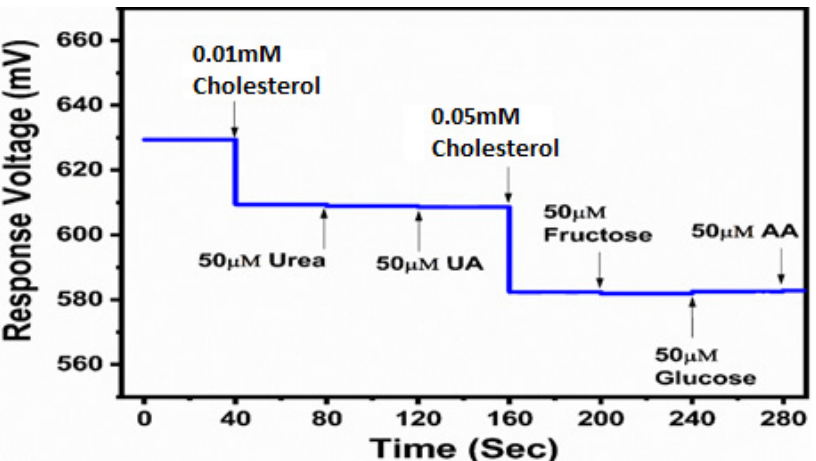
Figure 9. Selectivity response of cholesterol oxidase-immobilized Co 3 O 4 nanocrystals in 10 mM phosphate buffer solution of pH 7.3 in 0.01 and 0.05 mM cholesterol concentration with addition of 0.05 mM of common interfering substances.